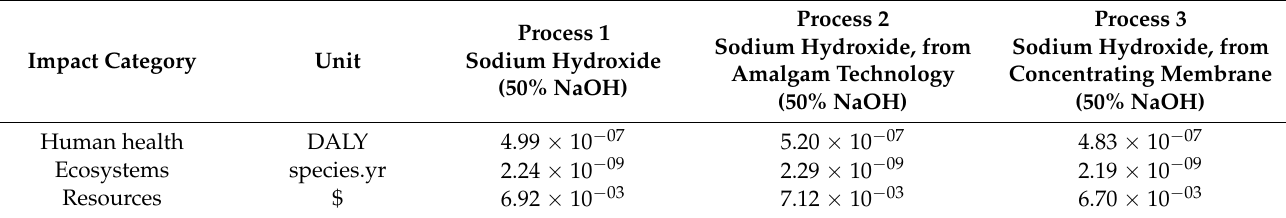
Table 6. The sensitivity analysis of NaOH production processes in Scenario